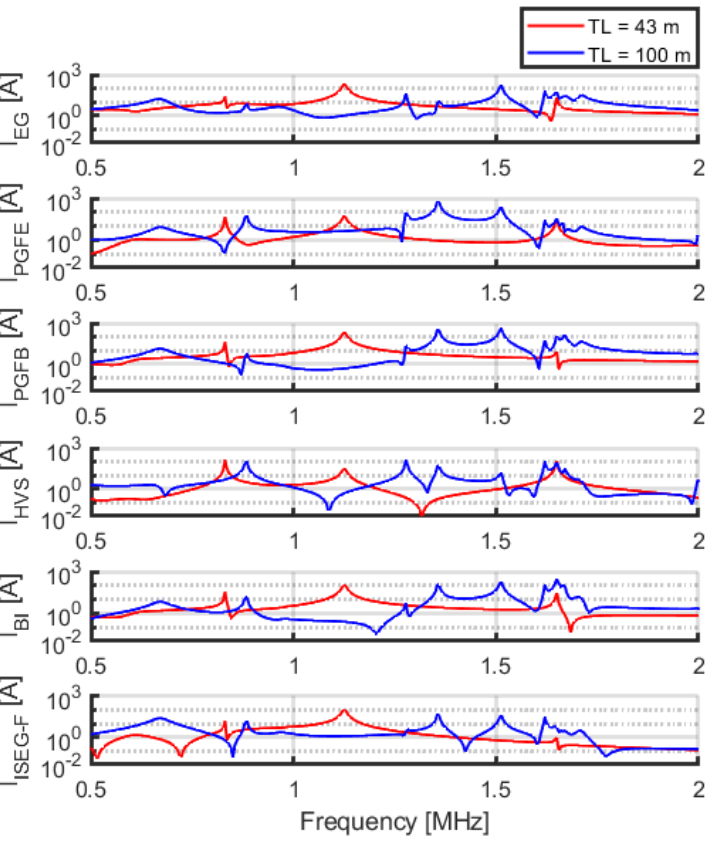
Figure 7. RF stray current resonances in SPIDER transmission line conductors and ISEG filter, in configuration with CVD installed at the secondary side of ISRF transformer. Two transmission line lengths are considered in the simulation, 43 and 100